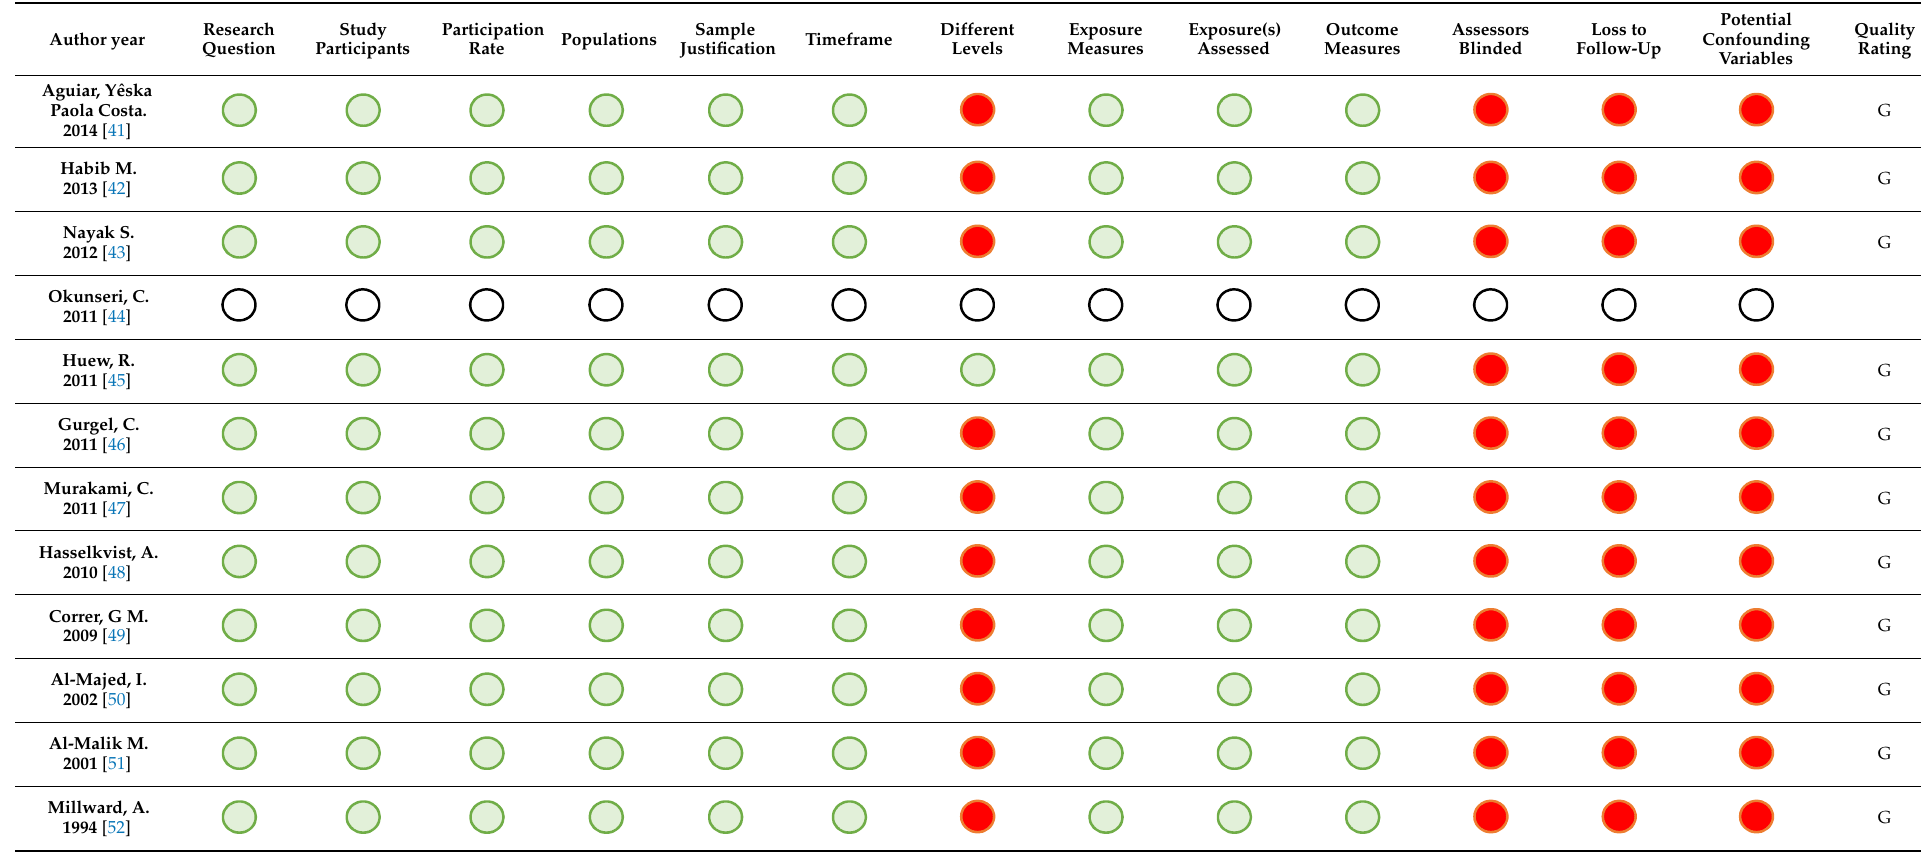
Table 2. The National Institutes of Health (NIH) quality assessment tool for observational cohort and cross-sectional studies. Website: https://www.nhlbi.nih.gov/health-topics/study-quality-assessment-tools (accessed on 27 November 2022) [53].